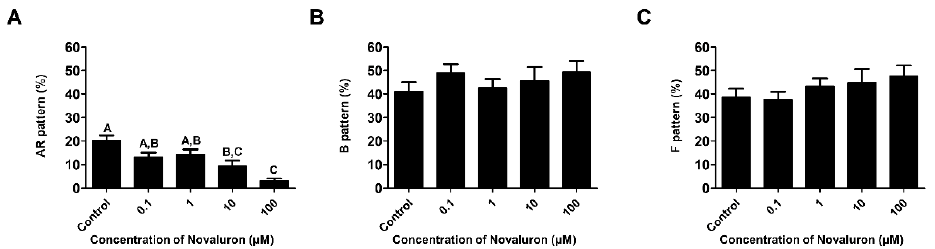
Figure 2. Effects of novaluron on capacitation status. ( A ) Patterns of live and acrosome-reacted sperms (AR pattern). ( B ) Patterns of live and capacitated sperms (B pattern). ( C ) Patterns of live and